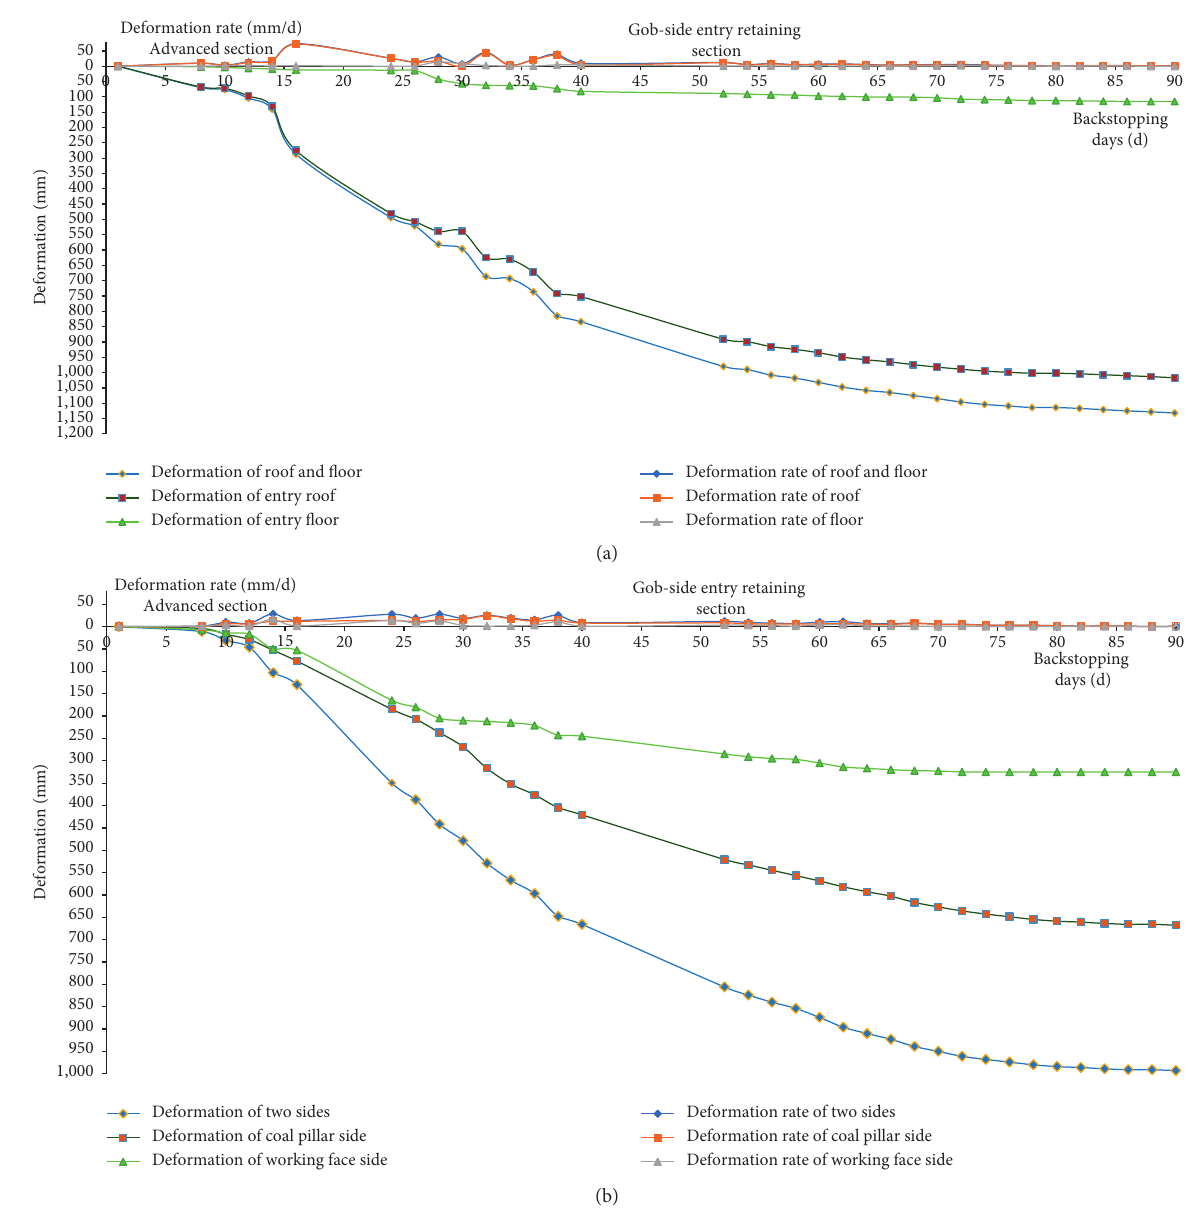
Figure 4: The deformation and deformation rate curve of the 2# measuring point. (a) I measuring surface. (b) II measuring